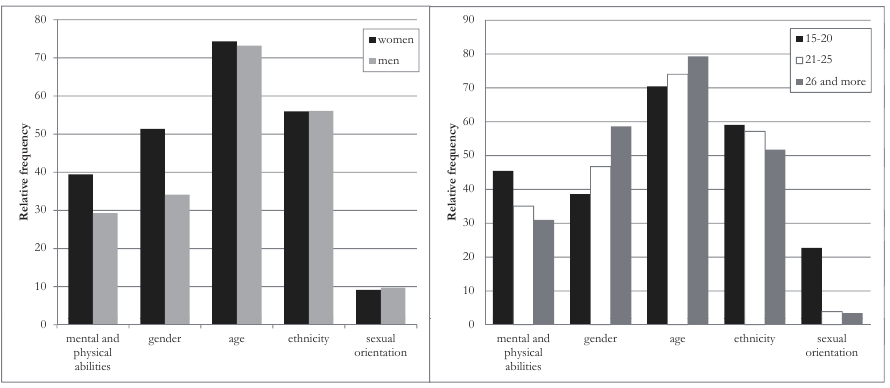
Fig. 5 - The most widespread discrimination in CR by women, men and individual age groups. Source: own process - ing,